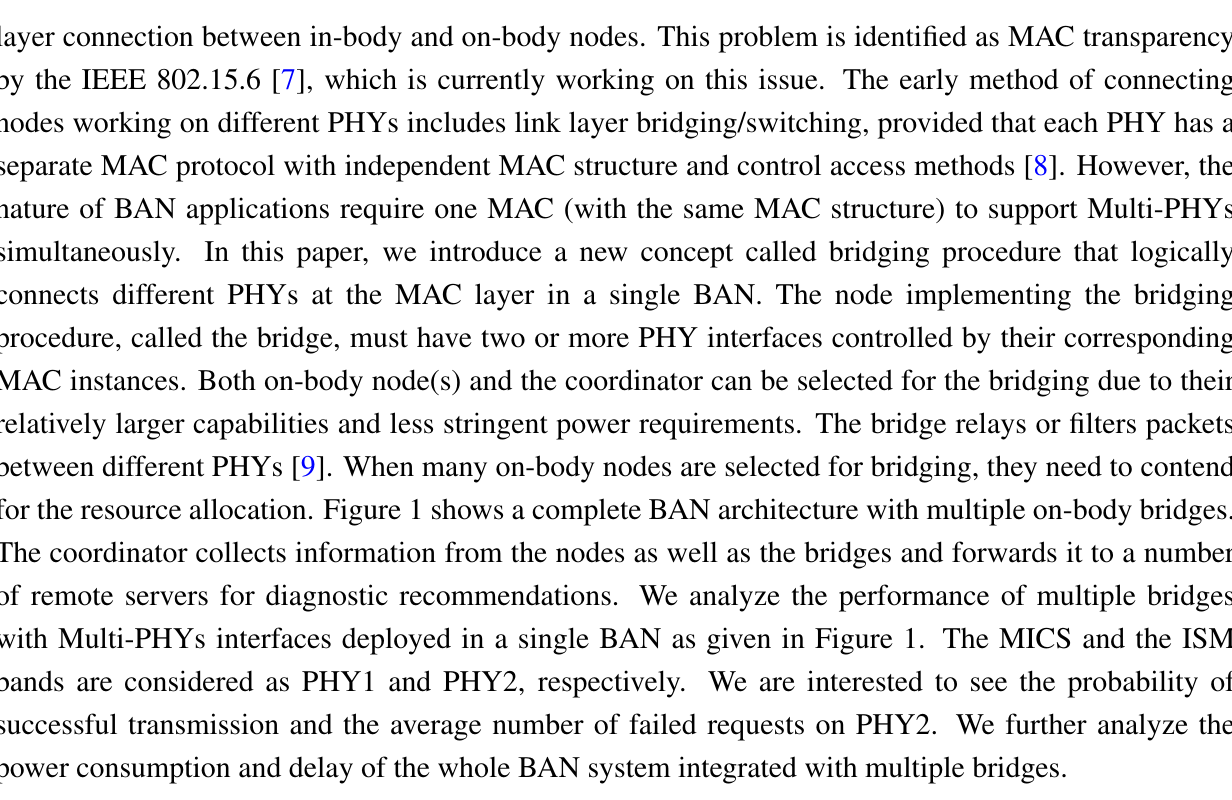
Figure 1. BAN architecture with multiple